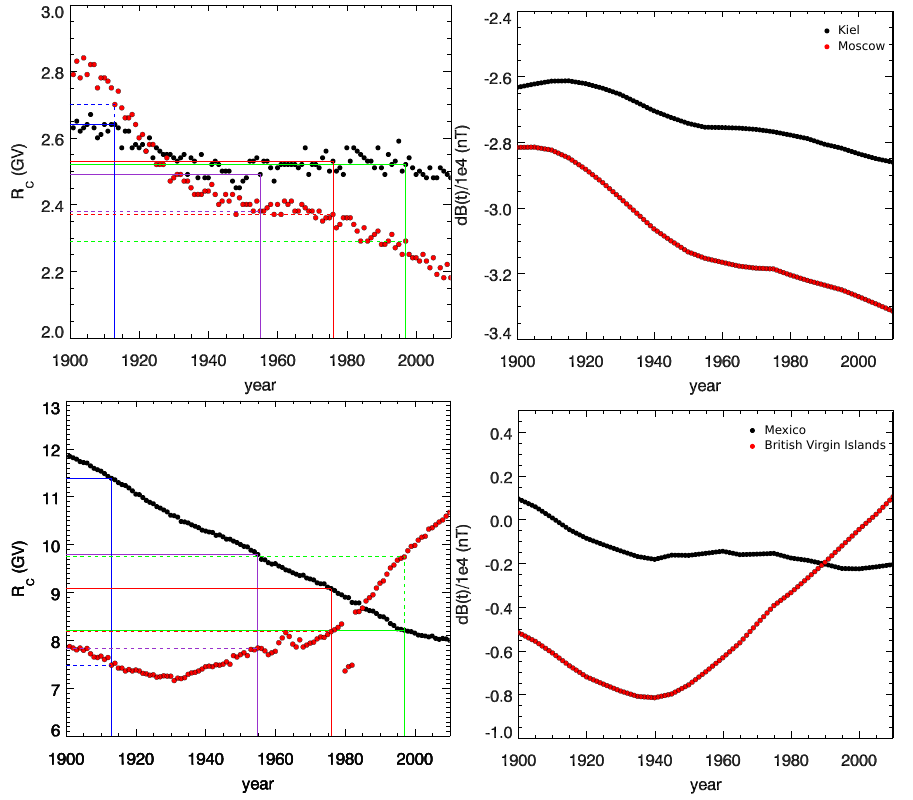
Fig. 6. Vertical cutoff rigidities (left panels) as well as δB values (right panels) for the time interval between 1900 and 2010 at Kiel (black dots) and Moscow (red dots) in the upper panels as well as Mexico City (black dots) and the British Virgin Islands (red dots) displayed in the lower panels. The colored lines represent the years 1913 (blue), 1955 (dark orchid), 1976 (red) and 1997 (green), with solid (dashed) lines for Kiel and Mexico City (Moscow and